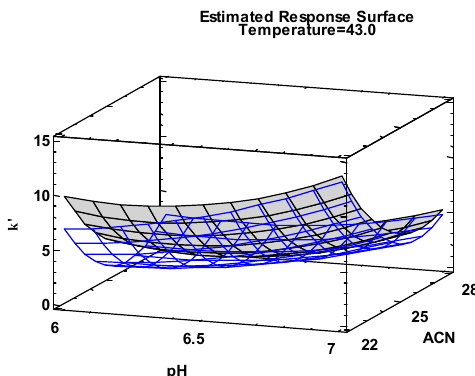
Figure 4. Overlaid response surfaces of AZT and EAIE. The blue and grey coloured surfaceslines represent the individual response surfaces of EAIE and AZT respectively.